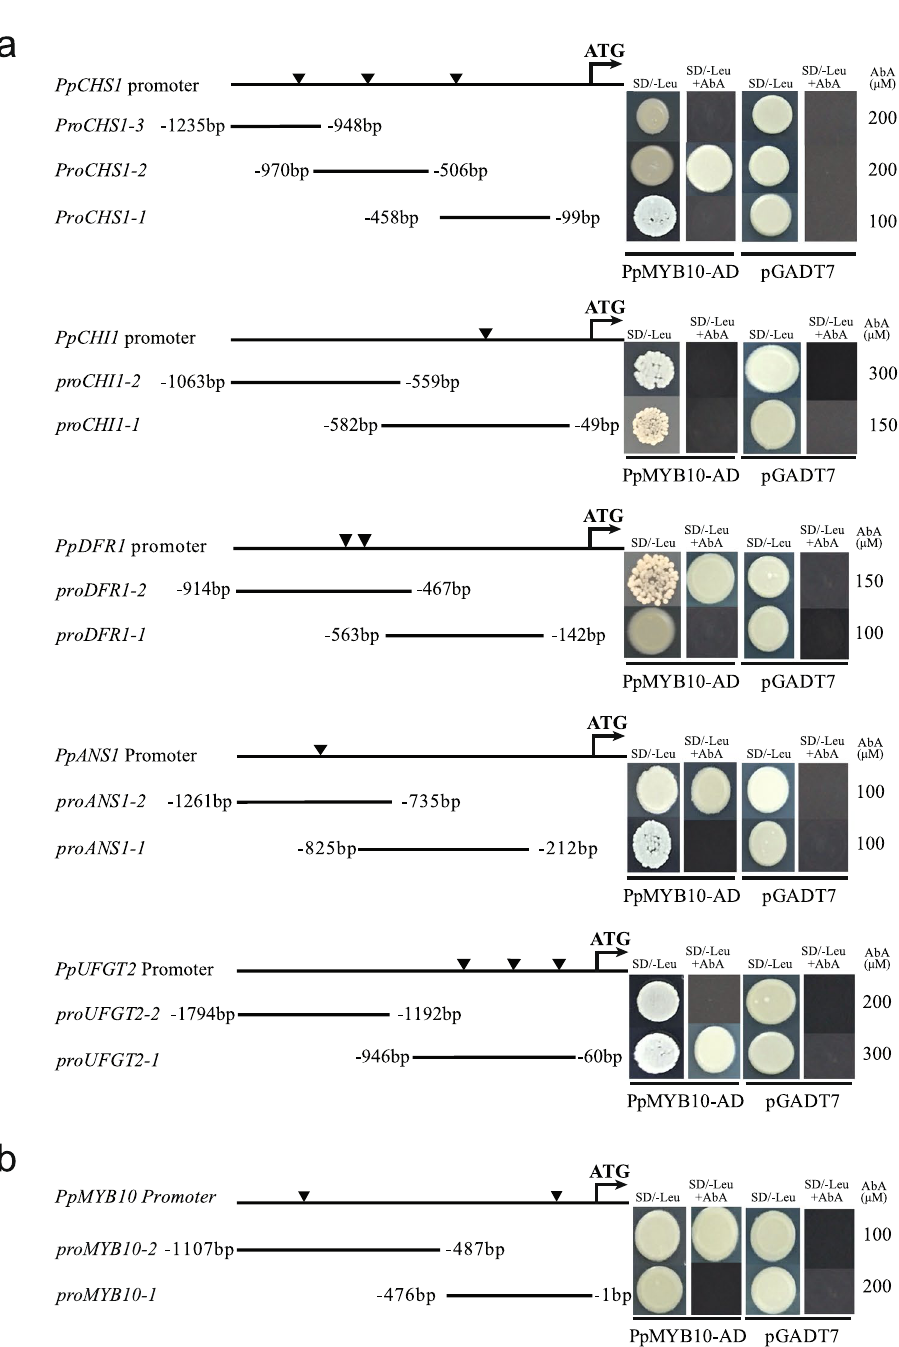
Figure 8. Direct binding of PpMYB10 on the promoter of anthocyanin biosynthetic structural genes ( a ) and PpMYB10 itself ( b ) of ‘Meirensu’ in yeast-one hybrid system. The tri-angle marked the conserved MYB binding domain predicted using